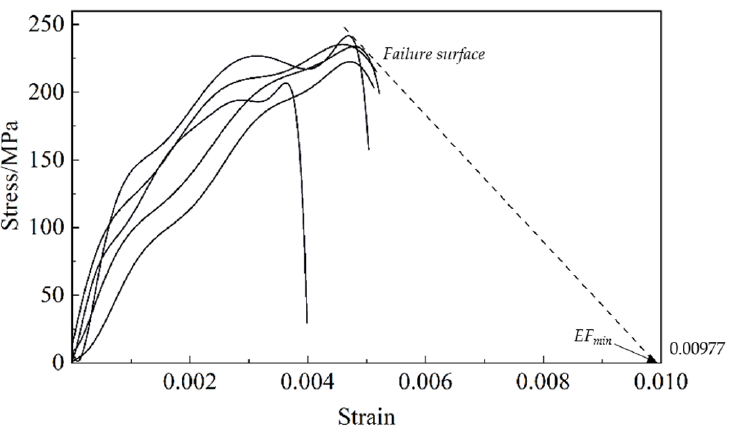
Figure 5. Technique for obtaining the value of EF min .